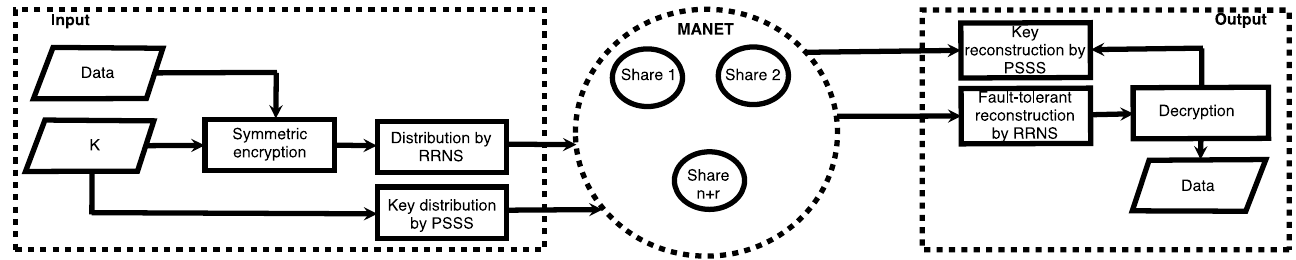
Figure 5. A generalized scheme for secure and reliable data transmission based on a computationally secure SSS.